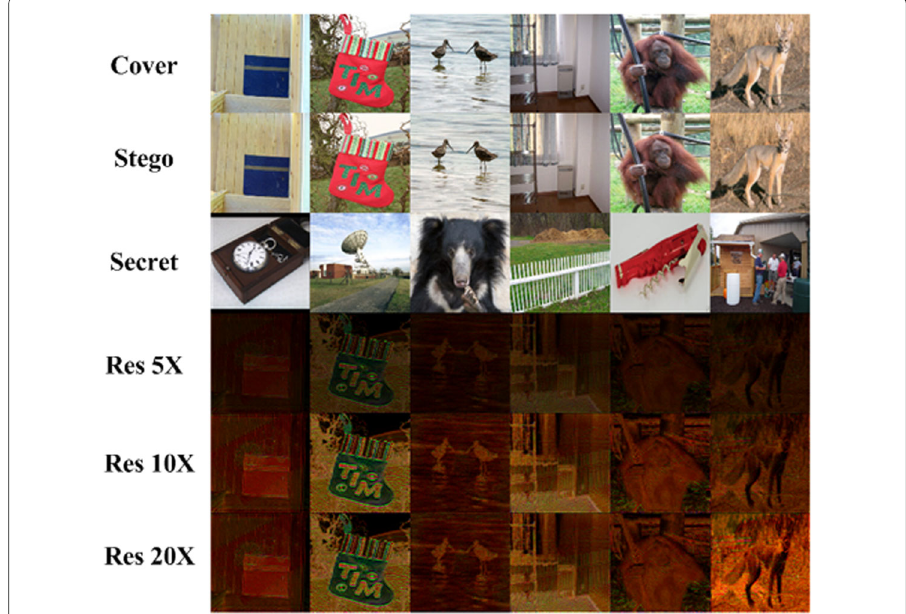
Fig. 4 The residual steganographic images generated by HIGAN. The first three rows are the cover images, the corresponding steganographic images generated by our model, and the secret images, respectively; the last three rows are the residual images obtained by the subtraction of the steganographic images and corresponding carrier images with 5 × , 10 × , and 20 ×